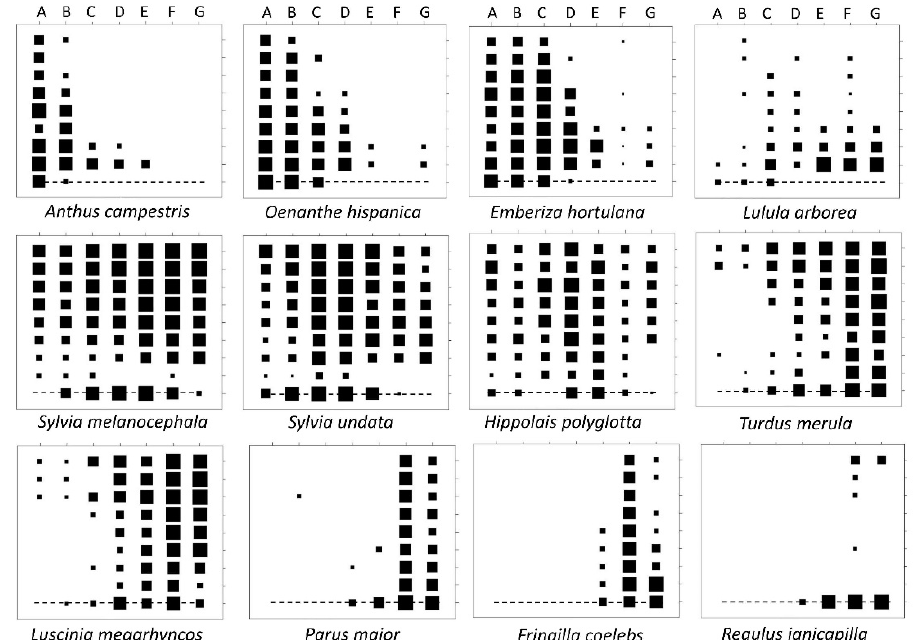
Figure 3. Mean occurrence frequency in 20-mn point counts of twelve common bird species in seven classes corresponding to a vegetation gradient from grasslands (A) to closed forests (G) ( x -axis), and the first eight years after a fire ( y -axis). Dashed line: the prefire gradient. (see Figure 2 for an illustration of the sampling design) The dimension of a square is normalized by the maximum frequency of the species considered.